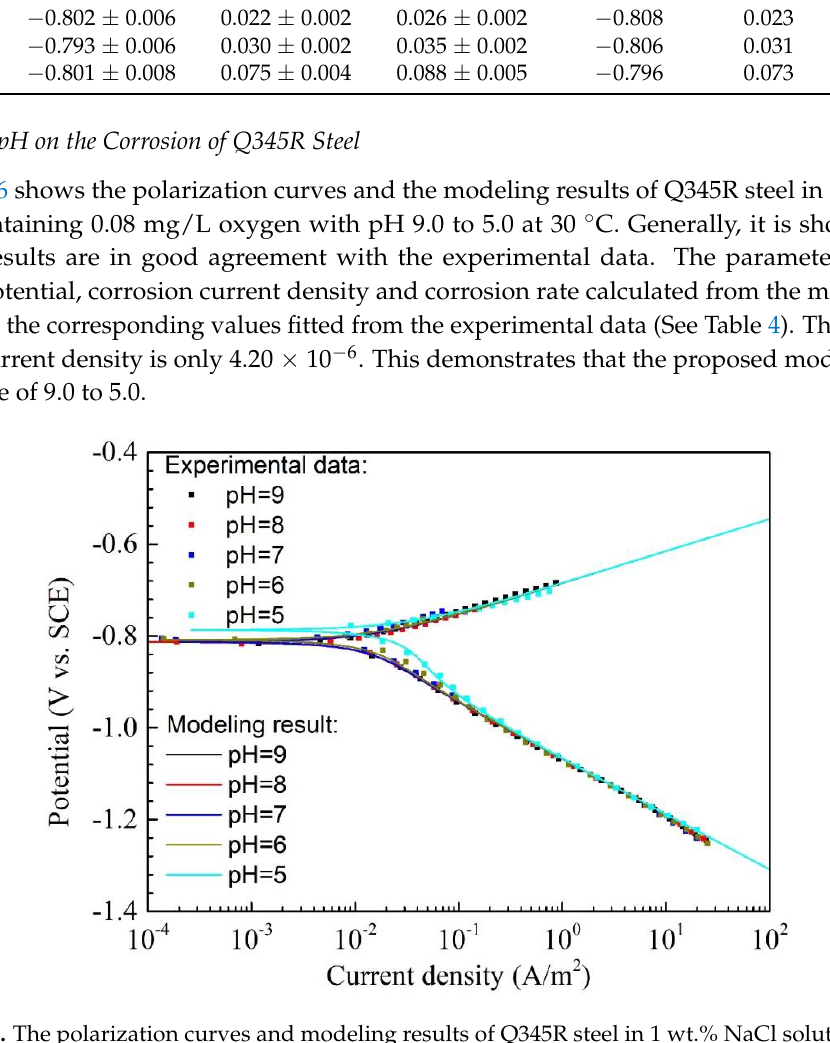
Table 4. The corrosion potential, corrosion current density and corrosion rate of Q345R steel in 1 wt.% NaCl solution with 0.08 mg/L oxygen at different pH under 30 °C, including the results fitted from the experiment data and calculated from the model.